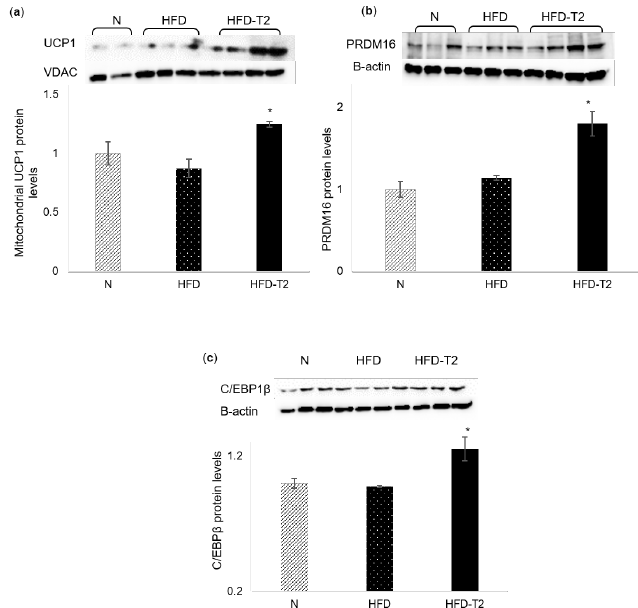
Figure 4. Effects of T 2 administration on expression of the main browning genes in sWAT. Western blot images and densitometry showing relative expression of the main browning genes in sWAT of